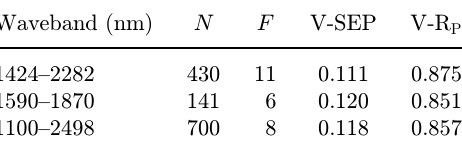
Table 3. Validation e®ects that correspond to the optimal MWPLS waveband, the equivalent optimal waveband, and to the long-NIR